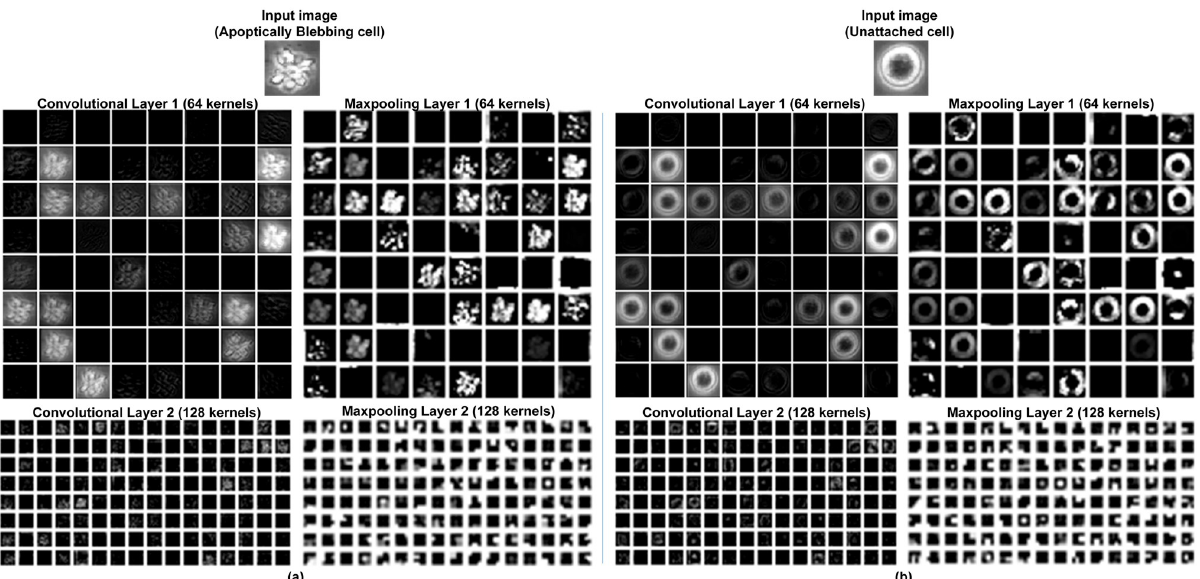
Fig 11. Visualization of features extracted by the CNN in DeephESC 2.0 for (a) Apoptically Blebbing cell and (b) Unattached cell .